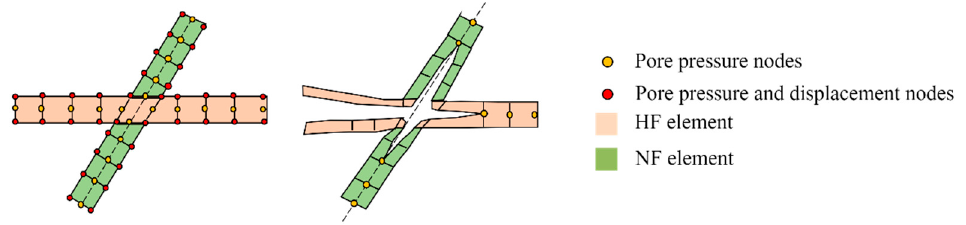
Figure 1. Schematic of the intersection between a hydraulic fracture and a natural fracture using pore pressure cohesive elements. Inspired by [32].